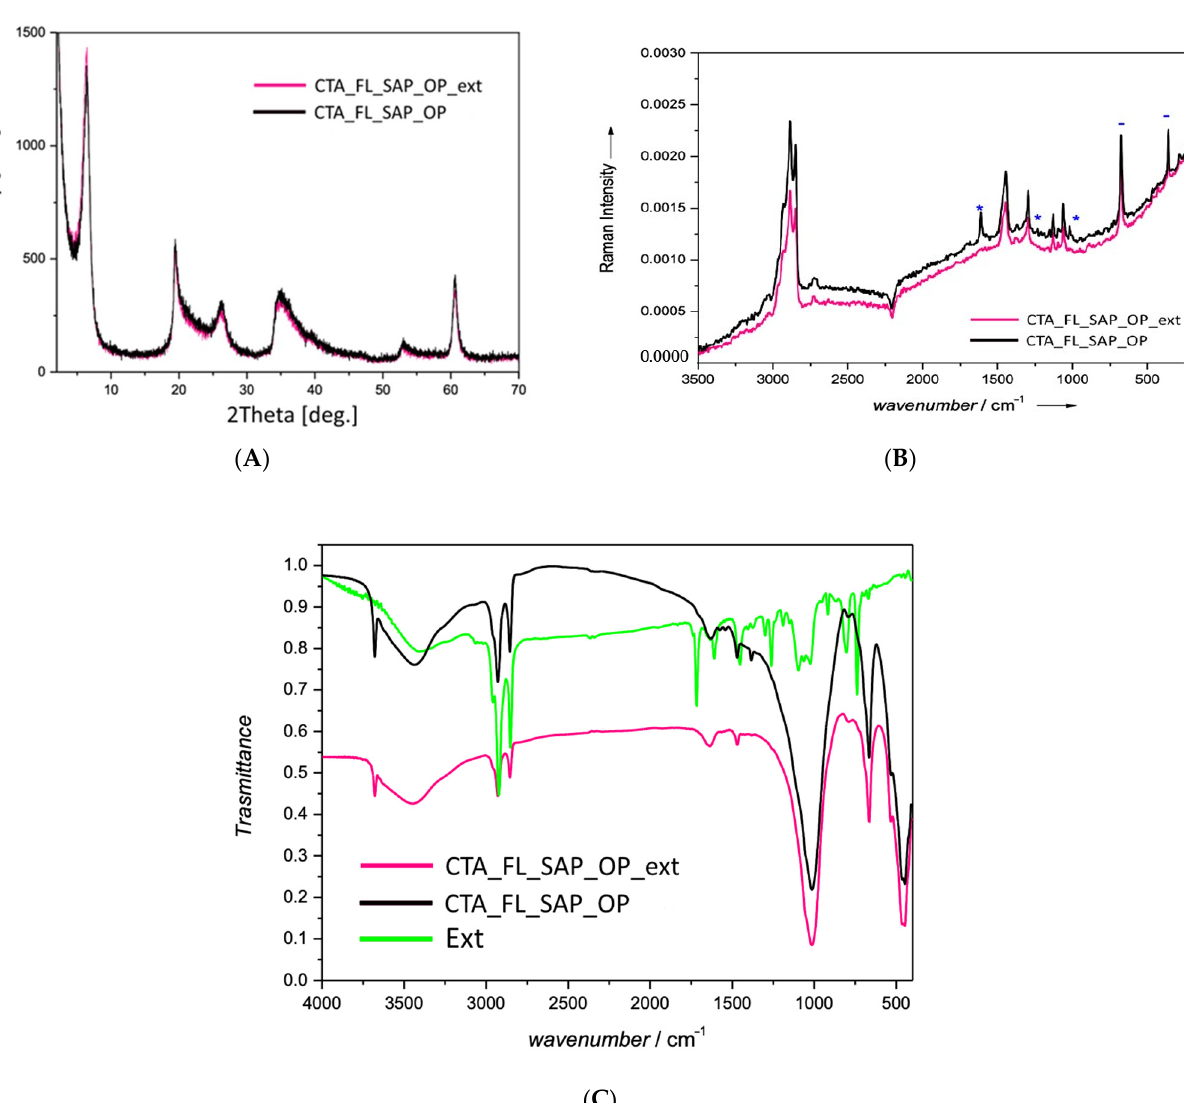
Figure 10. ( A ) XRPD pattern of the CTA_FL_Sap_OP sample before and after the extraction procedure, ( B ) Raman spectra of the CTA_FL_Sap_OP sample before and after the extraction procedure and ( C ) FTIR spectra of the CTA_FL_Sap_OP sample before, after the extraction procedure and of the extracted slurry (Ext).